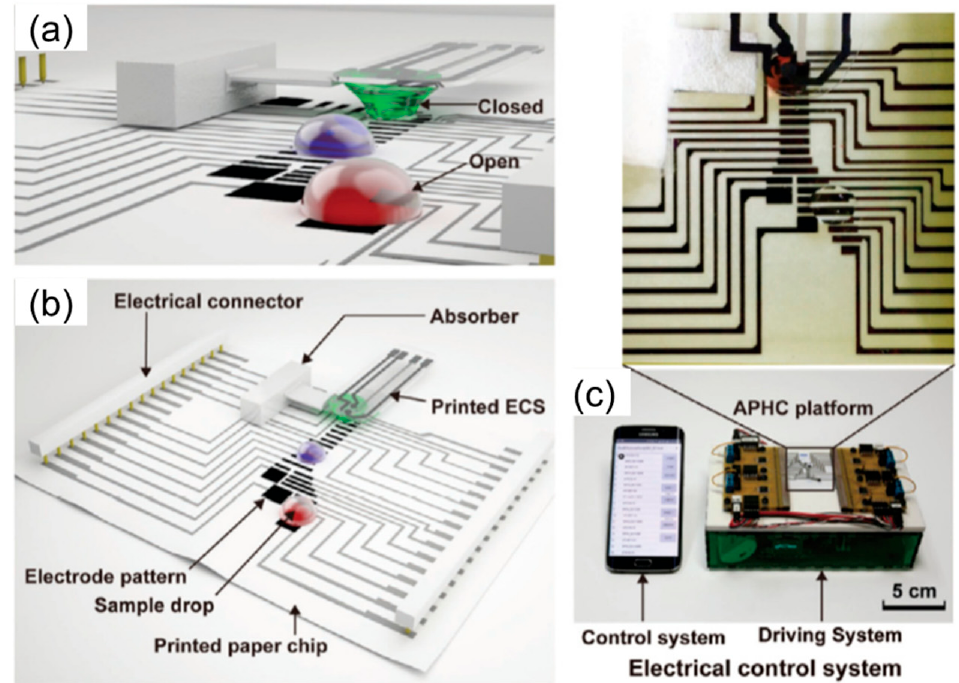
Figure 9. ( a ) Novel features of printed paper-based digital microfluidic chips include the partially open (blue and red drops) and closed (green drop) forms, ( b ) a modularly assembled active paper-based hybridized chip (APHC) platform, and ( c ) a combined wireless electrical control system with the chip platform, the driving system, and the mobile-based wireless control system. Reproduced with permission from the authors of [78]. Copyright 2017, WILEY-VCH Verlag GmbH & Co. KGaA, Weinheim.